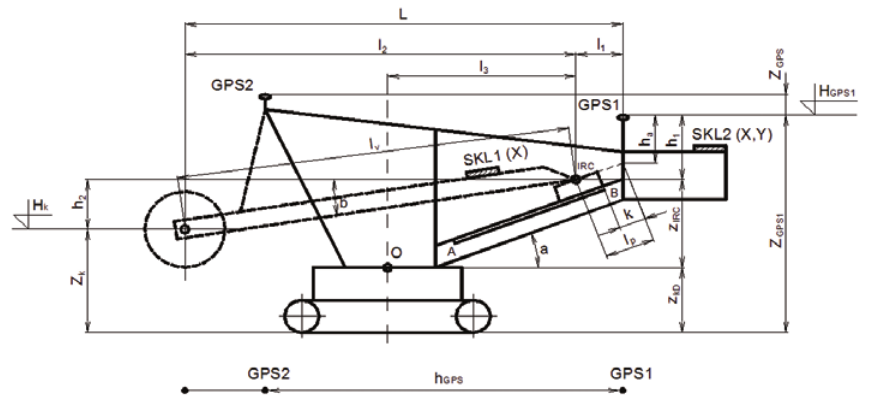
Fig. 6. Bucket-wheel excavator